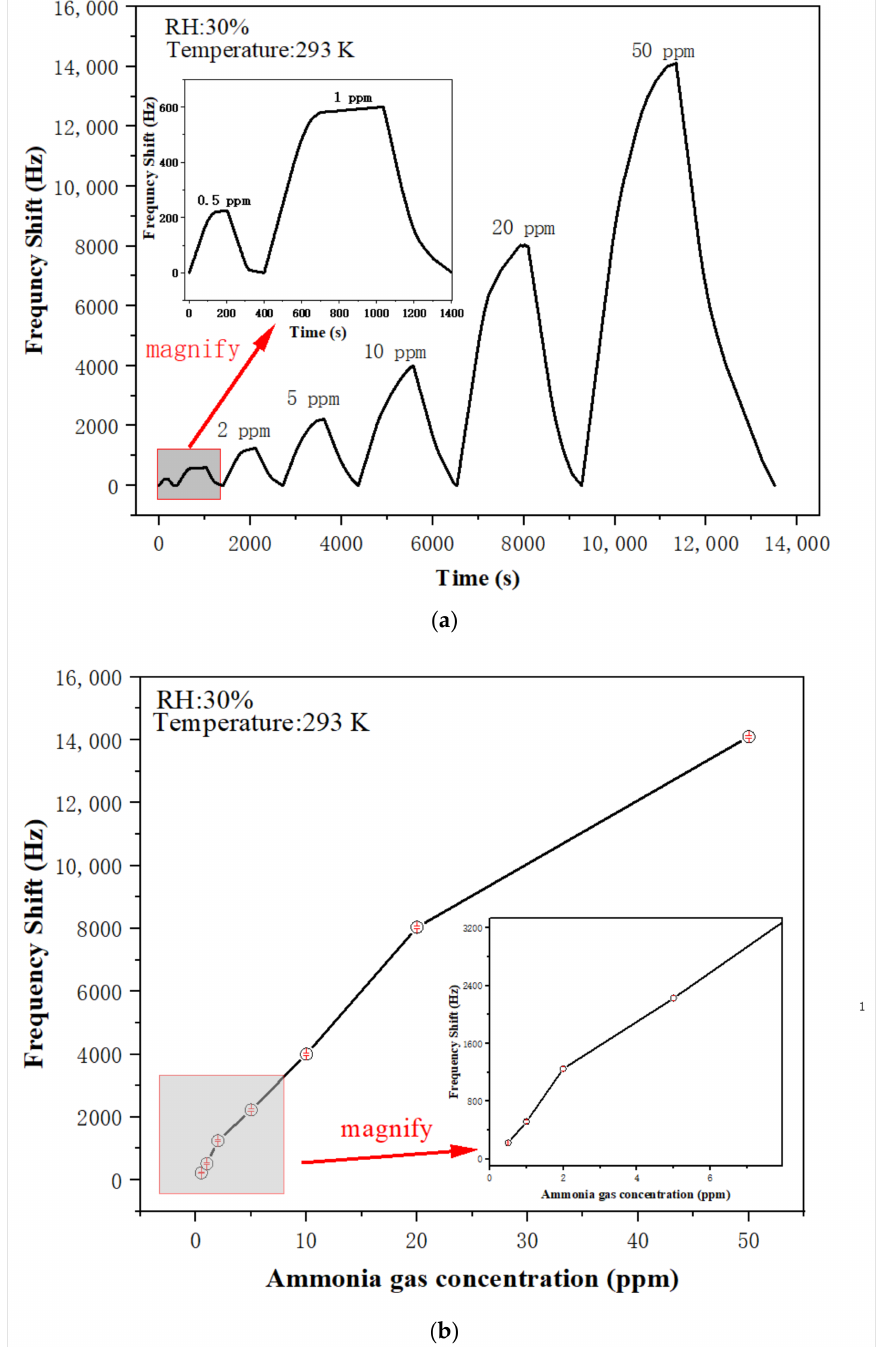
Figure 6. ( a ) Dynamic responses of PAASAW sensors to ammonia gases with different concentrations; ( b ) the relationship between frequency shift and ammonia gas